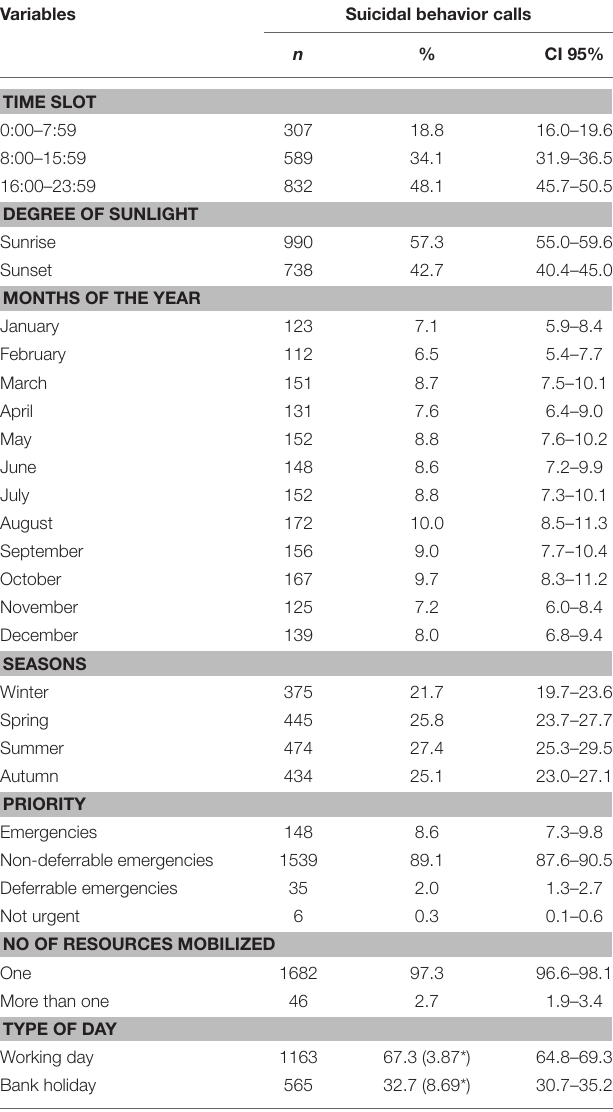
TABLE 4 | Distribution of suicidal behavior calls made to Prehospital Emergency Service by temporal and care variables.